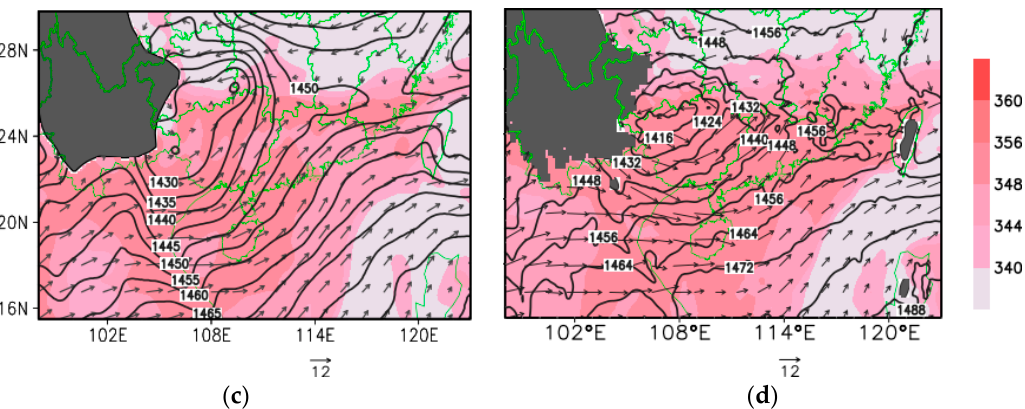
Figure 5. Comparison of the potential pseudo-equivalent temperature (shaded, K), horizontal wind, and geopotential height at 850 hPa (contours, 10 gpm) of ( a , c ) the ERA interim analysis data and ( b , d ) the D1 simulation results at 850 hPa at ( a , b ) 1800 UTC on 19 May and ( c , d ) 0000 UTC on 20 May 2015; the shaded region in gray indicates topography.